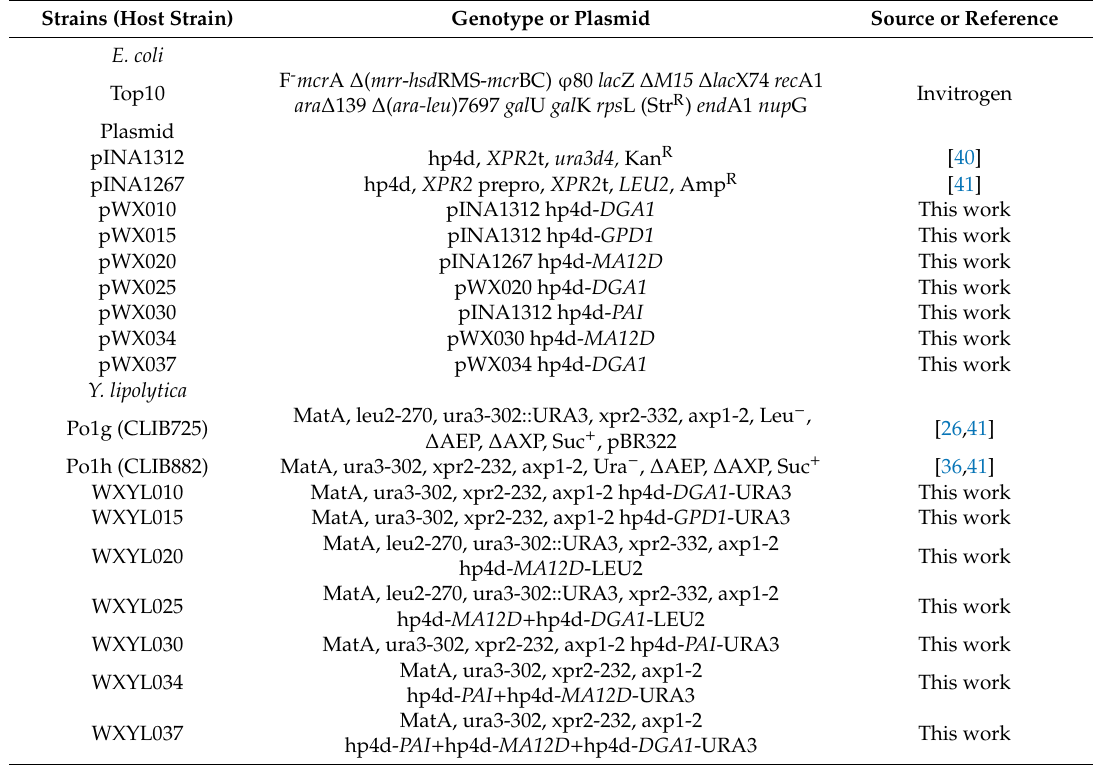
Table 1. Strains and plasmids used in this